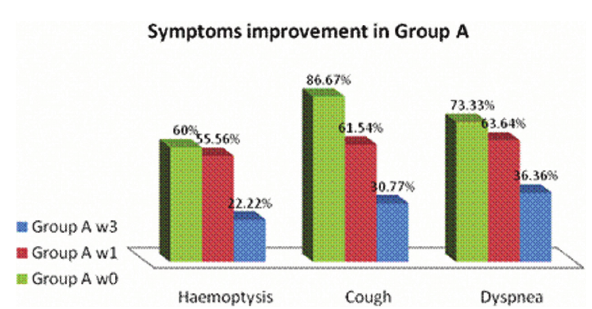
Symptoms improvement in group A (w0 = pre procedure, w1 = after 1 week and w3 = after 3 weeks).